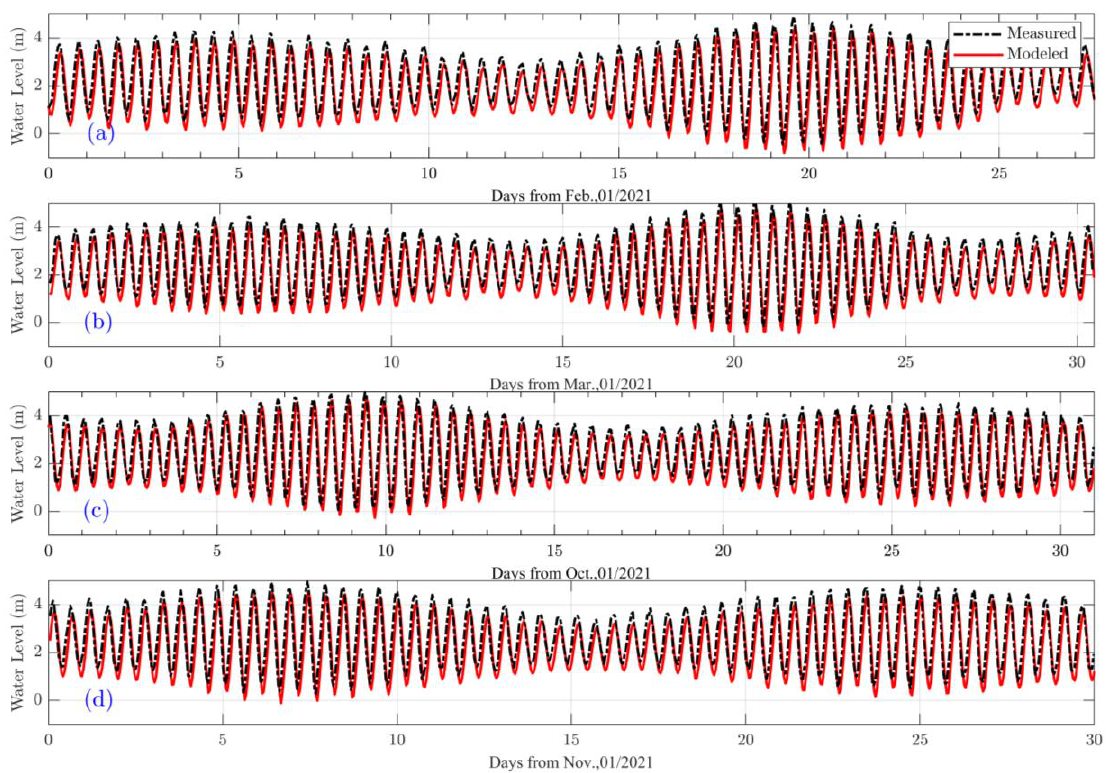
Figure 7. Sea water level comparison for simulations and measurements for ( a ) calibration in February, ( b ) calibration in March, ( c ) validation in October, and ( d ) validation in November.